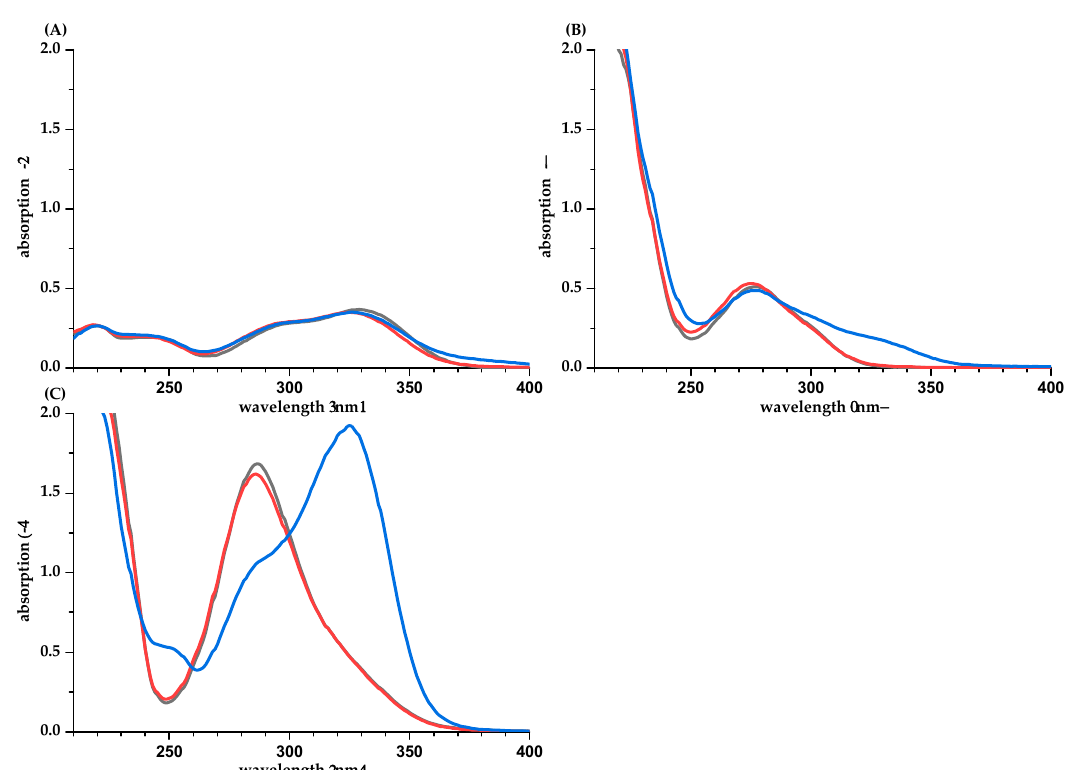
Figure 4. UV spectra of CA ( A ), EGCG ( B ), and PHL ( C ) in water/methanol (50/50, v/v , blue), water (orange), and phosphate buffer pH 7.5 (gray).